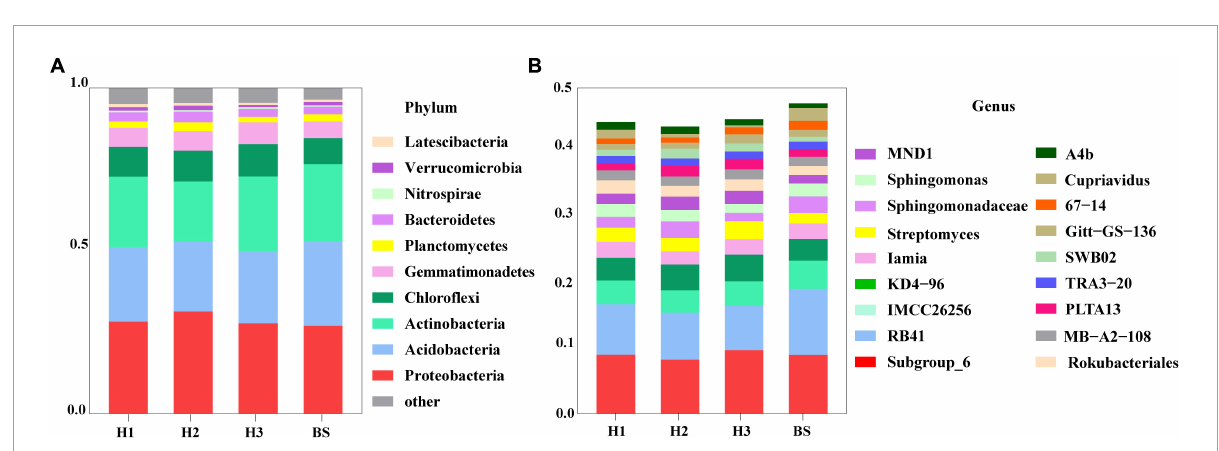
FIGURE2 The composition of bacterial community in rhizosphere and bulk soils at the level of phylum (A) and genus (B)